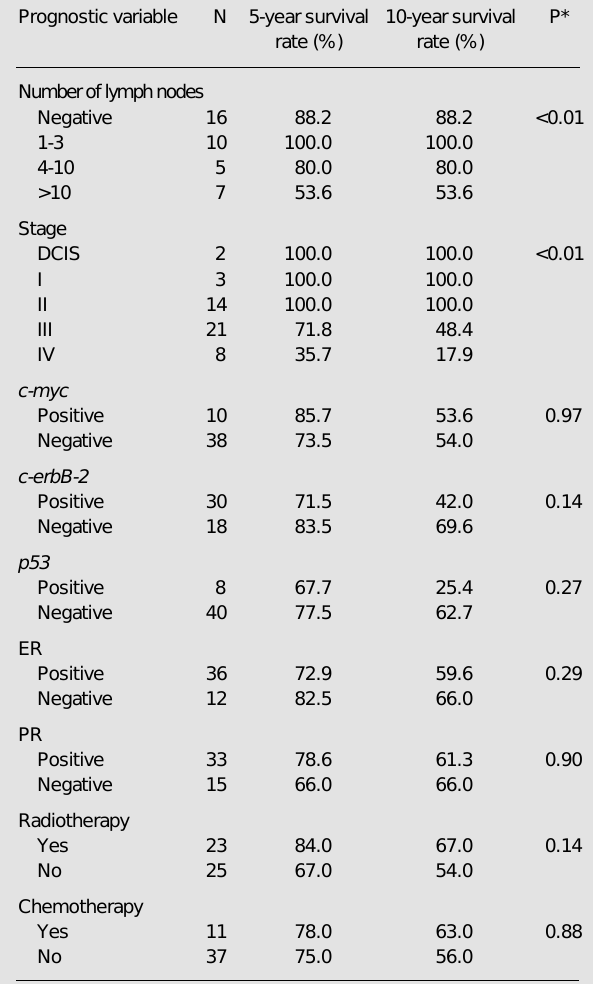
Table 3. Association of clinical, pathological and molecular markers and treatment features with specific survival. Prognostic